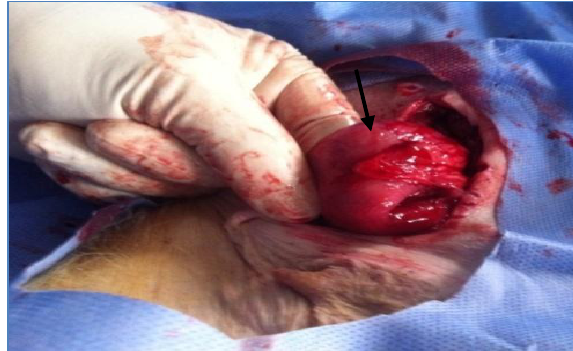
Figure, 1: Gross appearance of colon, shows severe adhesions at colonic incisional sites (arrow), beginning of vascularization (grade, 3), 7 days post-operation in group A.